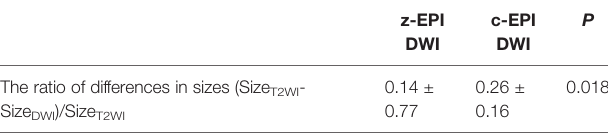
TABLE 4 | The ratio of differences regarding hilar cholangiocarcinoma lesion sizes on T 2 WI and DWI (b=800 s/mm 2 ).